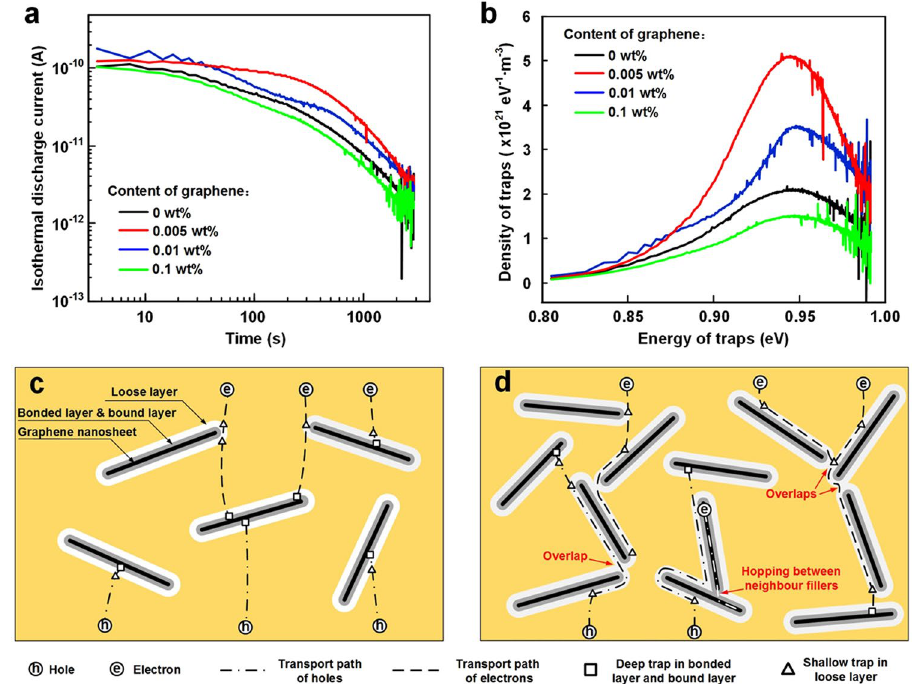
Figure 4. ( a ) Isothermal discharge current of LDPE/graphene NCs as a function of depolarization time. ( b ) Trap level distributions of LDPE/graphene NCs. ( c ) Schematic model for illustrating the deep trap modulated charge carrier transport. ( d ) Schematic model for illustrating the charge carrier transport through the overlaps of interaction zones and the thermally-activated field-enhanced hopping between neighbor